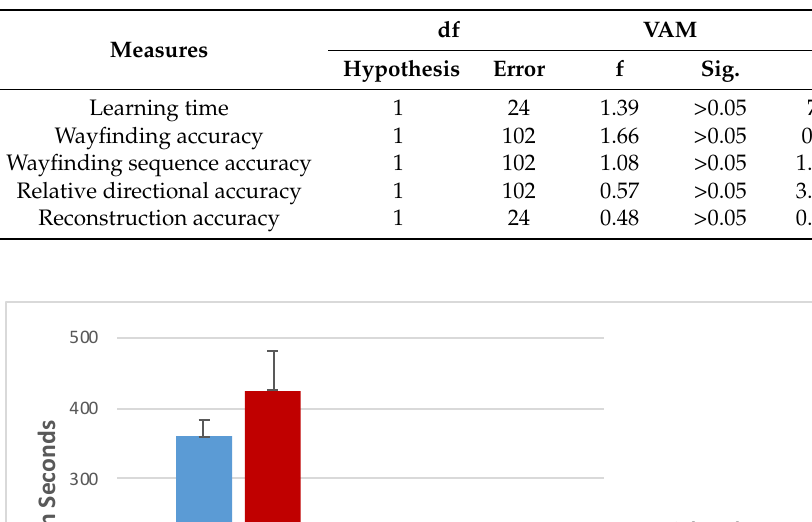
Table 7. ANOVA results comparing the participant groups for each of the dependent tested measures.